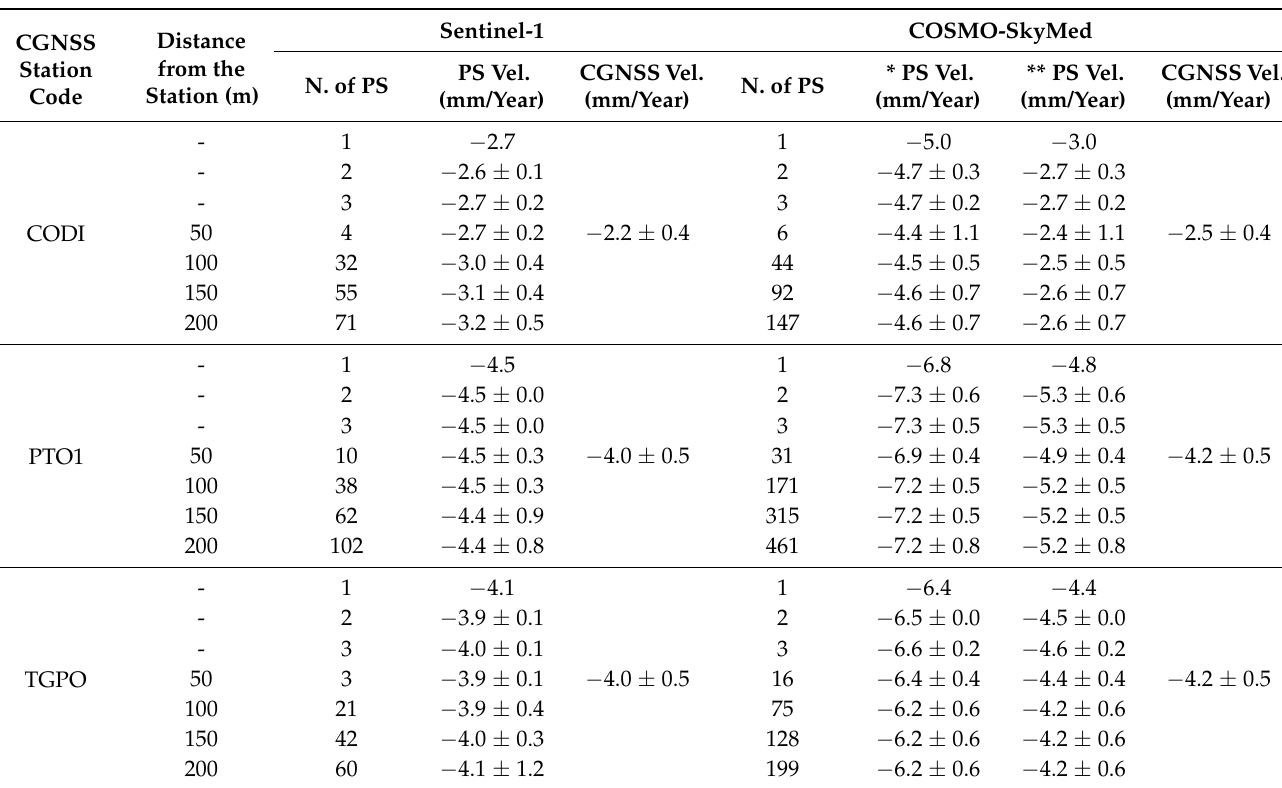
Table 2. Comparison between the vertical velocities of CODI, PTO1, and TGPO CGNSS measurements projected along the LOS of the satellites and PS points located up to 200 m from the permanent